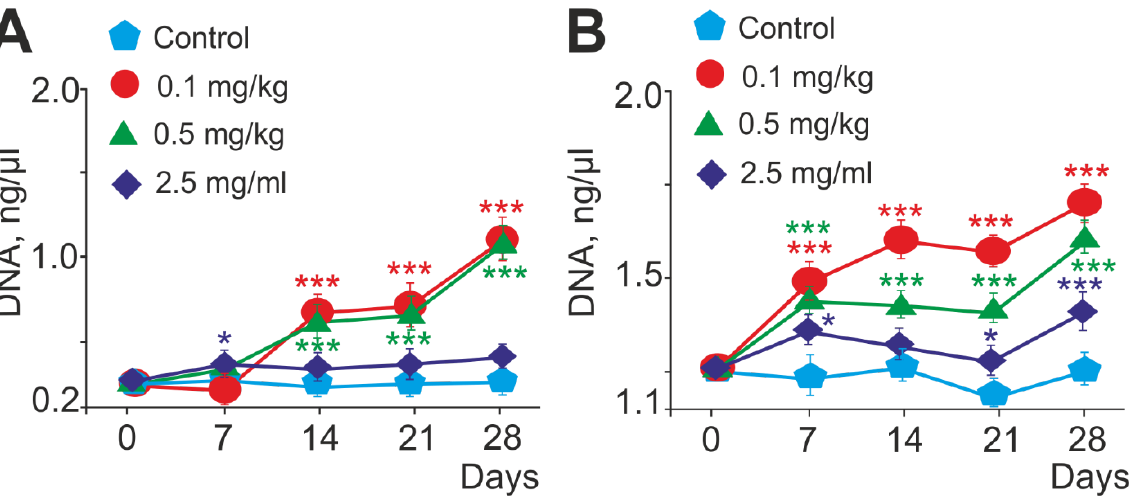
Figure 6. SeNPs modified unstimulated and stimulated NETs formation in a dose-dependent manner. NETs were released by unstimulated (neutrophils alone) ( A ) and stimulated (neutrophils + 1 mg/mL zymosan) ( B ) neutrophils: the control group (saline)—blue, groups with SeNP injection—0.1 mg Se/kg (red), 0.5 mg Se/kg (green), 2.5 mg Se/kg (dark blue). The NETs quantification estimated 0, 7, 14, 21, and 28 days after SeNPs or saline (control) were injected daily. NETs were identified as quantification extracellular DNA of supernatants from neutrophils using fluorometric DNA quantification assay (Pico488 DNA quantification kit) at 503 nm excitation wavelength and at 525 nm detection wavelength. Neutrophils were isolated from eight animals for each experimental group. Data are shown as mean ± SEM. Statistical analysis of experimental groups versus control was performed with paired t -test. Significance between group means: *** p < 0.001 and * p < 0.05. Values not marked with an asterisk are n/s — no significance.